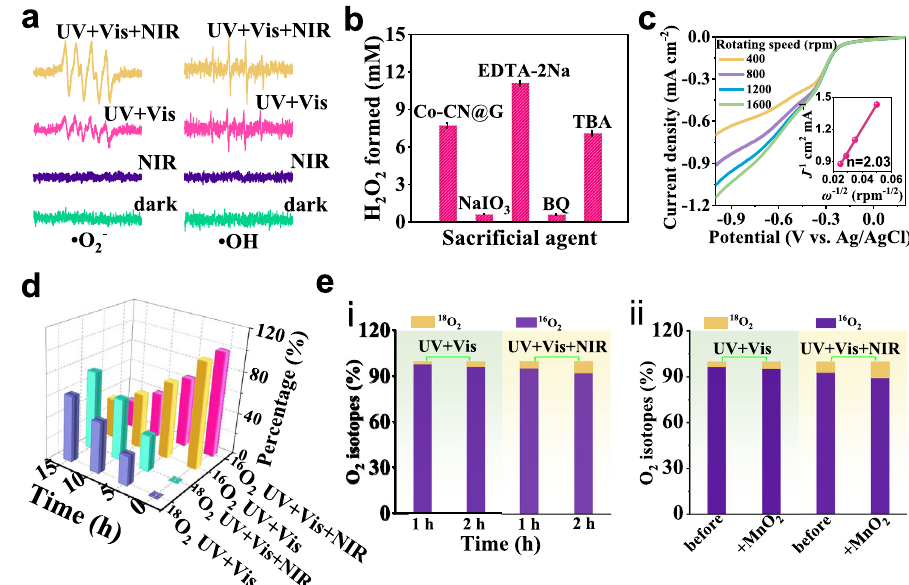
Fig. 4 | Photocatalytic mechanism of Co – CN@G for H 2 O 2 production. a EPR signals of (cid:129) O 2 − and (cid:129) OH over Co – CN@G in the presence of DMPO under different photoirradiation. b Photocatalytic H 2 O 2 generation for 6h over Co – CN@G with different sacri fi cial agents. c LSV curves of Co – CN@G measured on an RDE at different rotating speeds. Inset: the corresponding Koutecky – Levich plots. d 18 O 2